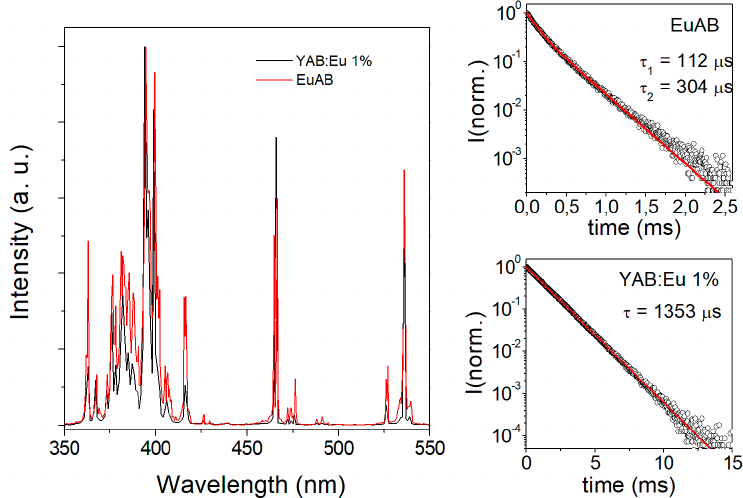
Figure 4. Comparison between the excitation spectra of Eu 3+ :YAB and EuAB, and decay profiles of their luminescence.